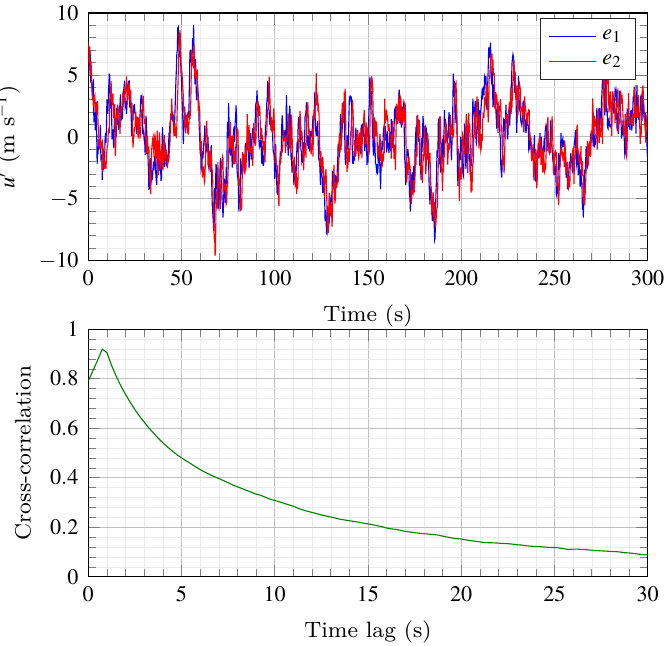
Figure 8. First five minutes of the time series of the fluctuating along-wind velocity components generated on e 1 and e 2 ( top panel ) and associated cross-correlation function ( bottom panel